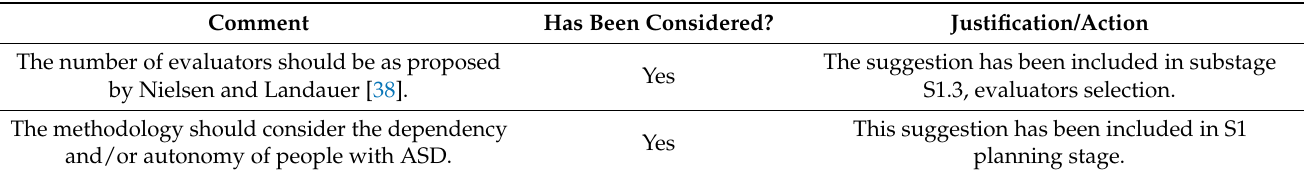
Table 6. Results of question